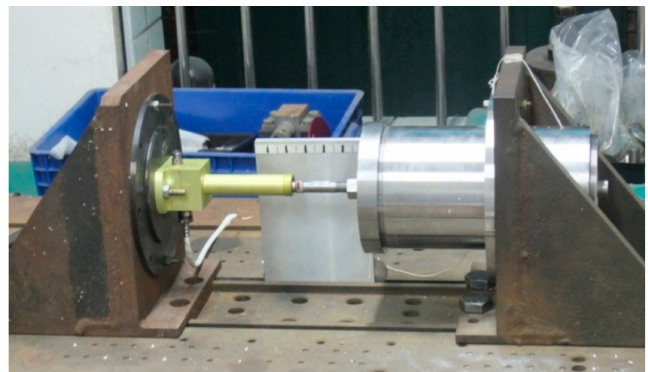
Figure 8. The test tooling of aluminum honeycomb type of measuring device.